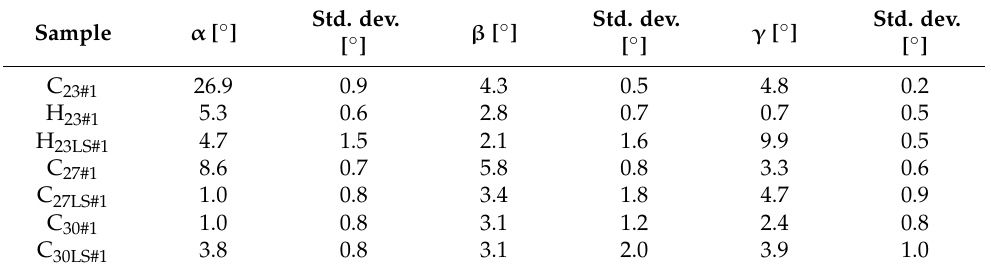
Table 3. Silicon content in samples [wt. %]. Standard uncertainty value 0.1 %. EDS.